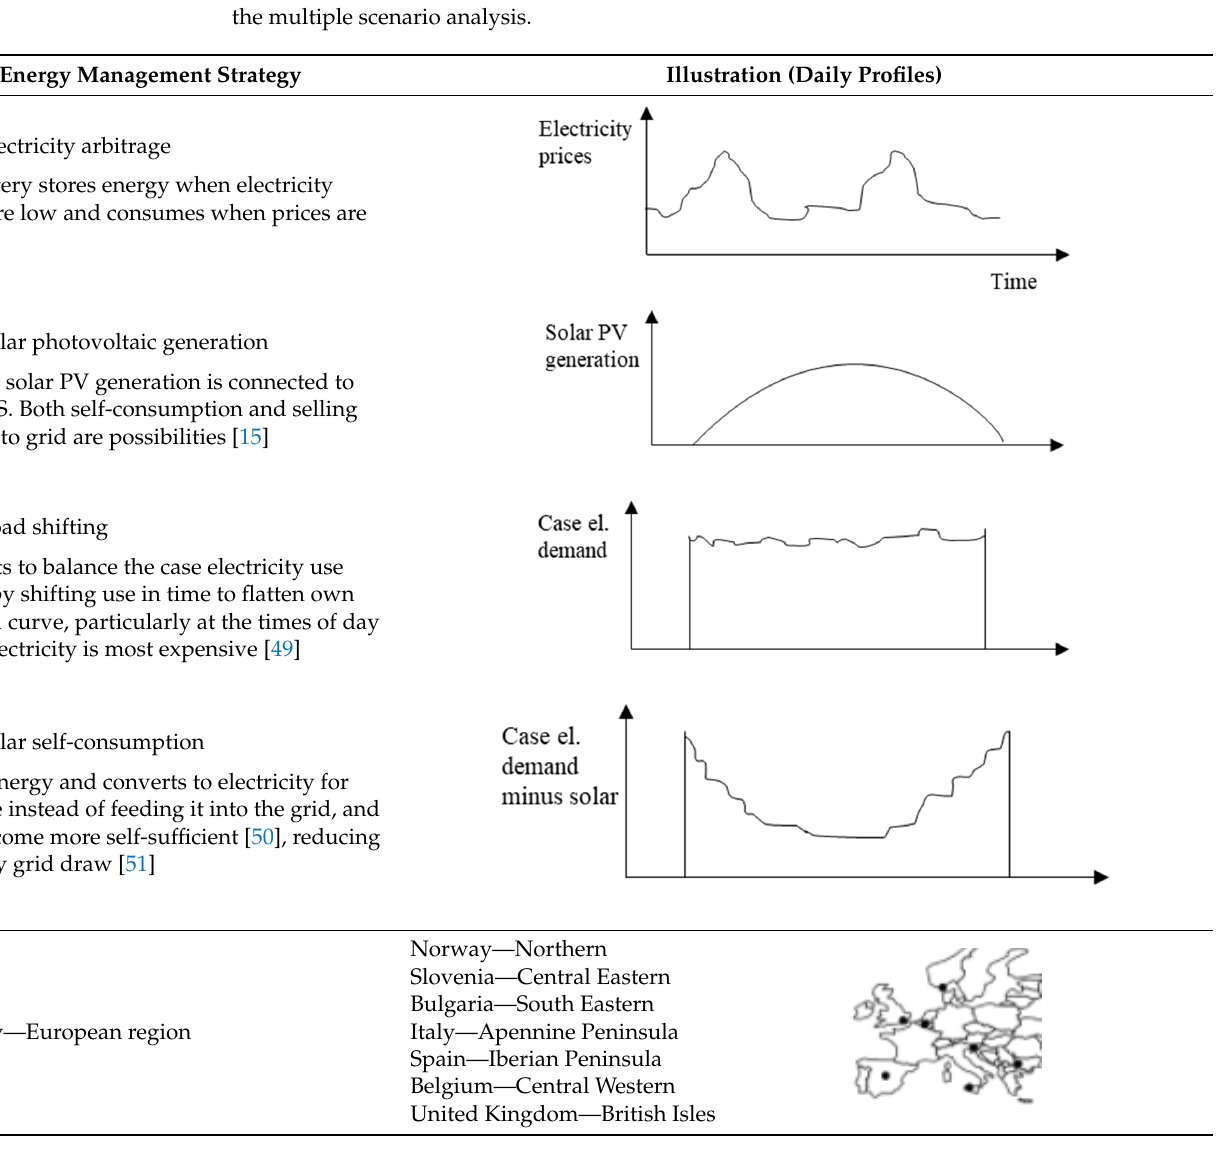
Figure 1. Illustrated study scope. Each EM strategy studied had an incentive for when the battery charges/discharges. These were simulated for seven European countries to consider country-specific and regional characteristics that can influence economic savings. The strategies applied are described and illustrated in Table 1. Table 1. The four energy management strategies and the European countries and regions covered in the multiple scenario analysis.